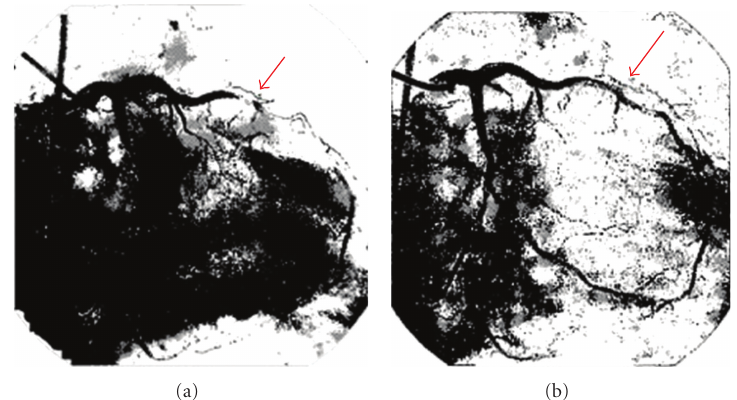
Figure 1: Left circumflex artery before (a) and after (b) stent placement during the patient’s third cardiac